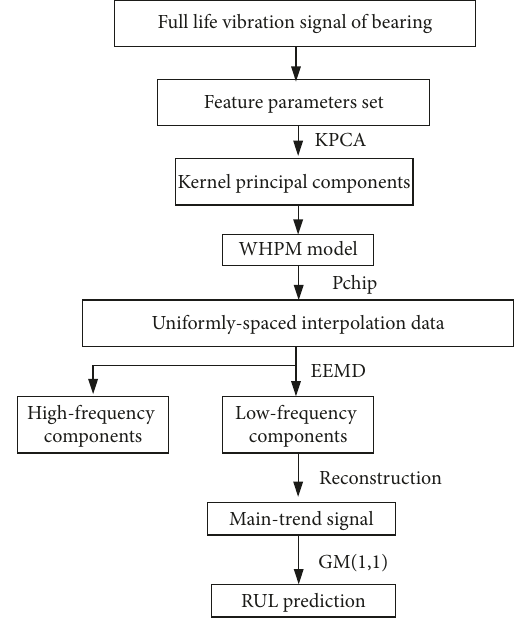
Figure 1: The flowchart of the proposed method.